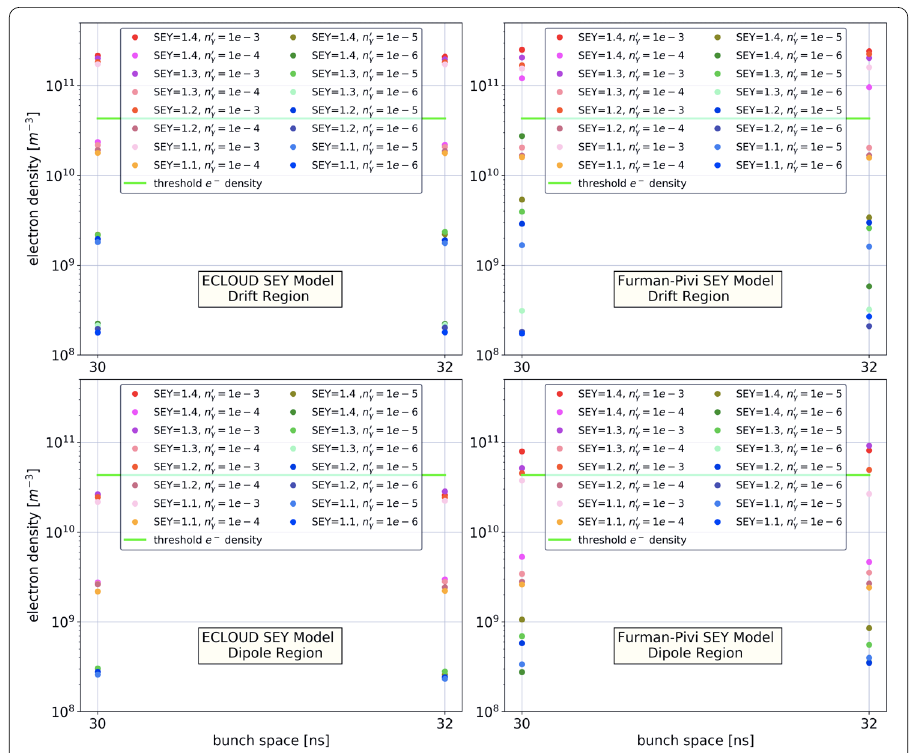
Figure 8 Simulated electron densities at the center of the beam pipe for the FCC-ee arc dipole & drift regions using the new baseline beam parameters for four IPs